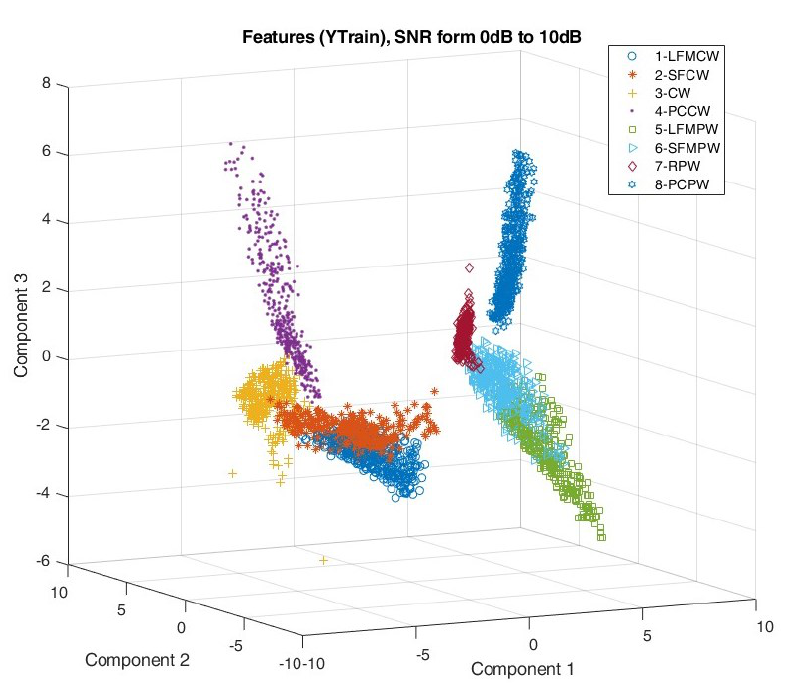
Figure 14. First three components after feature dimension reduction using PCA for SNR in range [0:10]